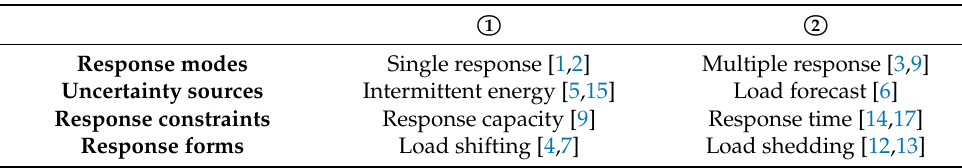
Table 1. Categories of DR operation characteristics.